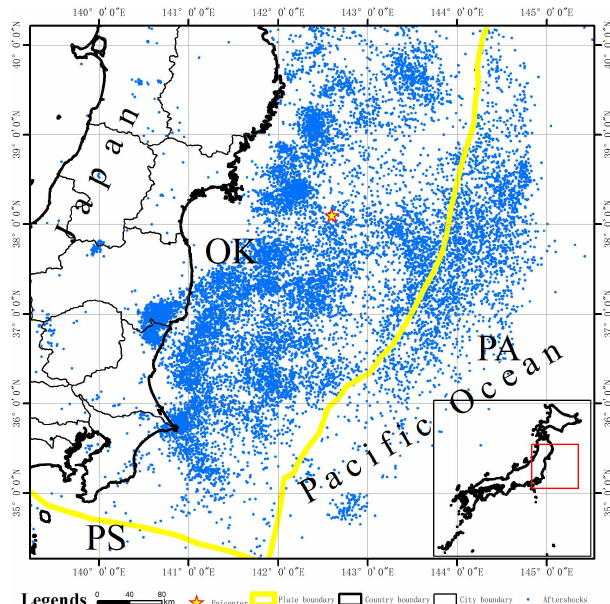
Figure 9. Aftershocks distribution of the Tohoku earthquake. The blue points in the figure are the projection positions of the after- shocks within a depth of 50km.